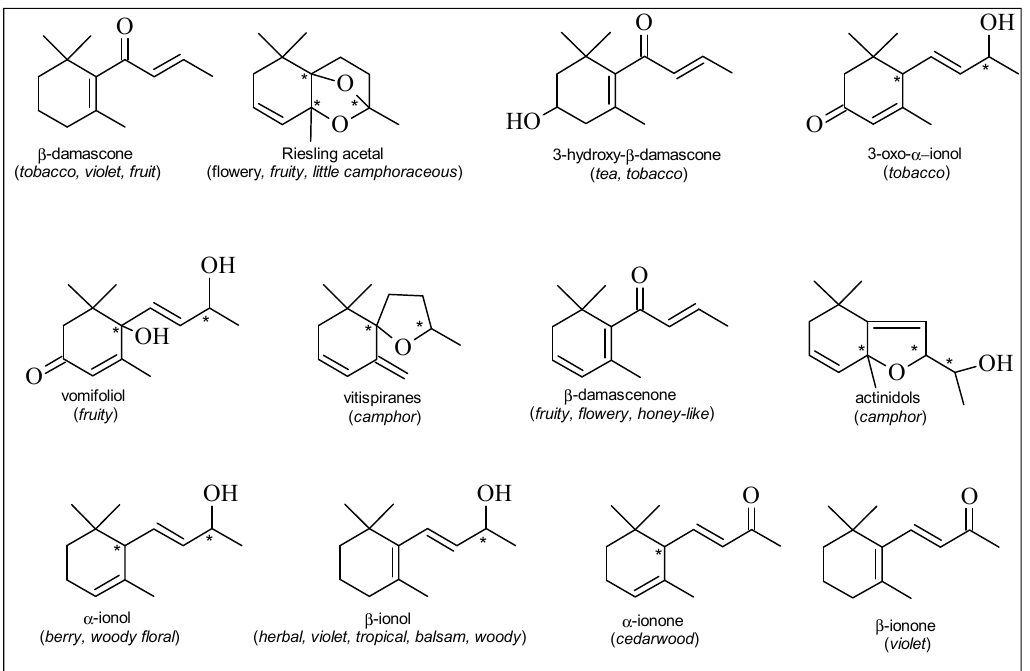
Figure 2. Principal C 13 -norisoprenoids identified in grapes. In brackets, the odor descriptor is reported